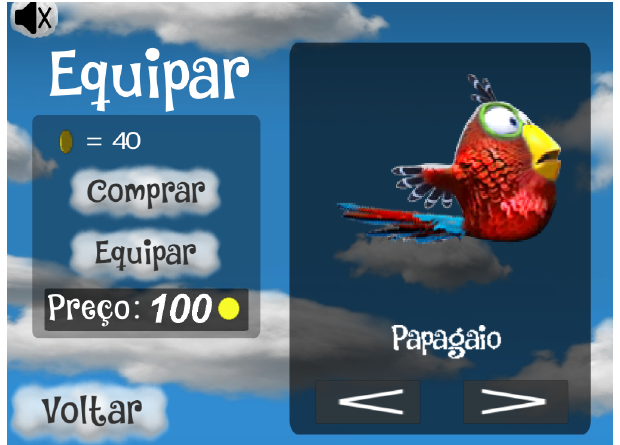
Figure 7. Personalize menu of the